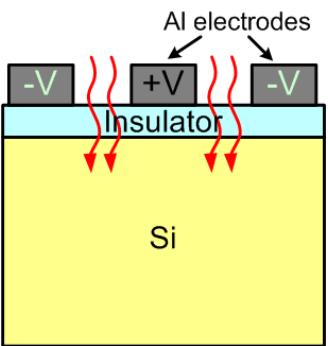
Figure 14. The schematic structure of a metal-insulator-semiconductor-insulator-metal photodetector. Both the anode and cathode electrodes were on the thin-insulator